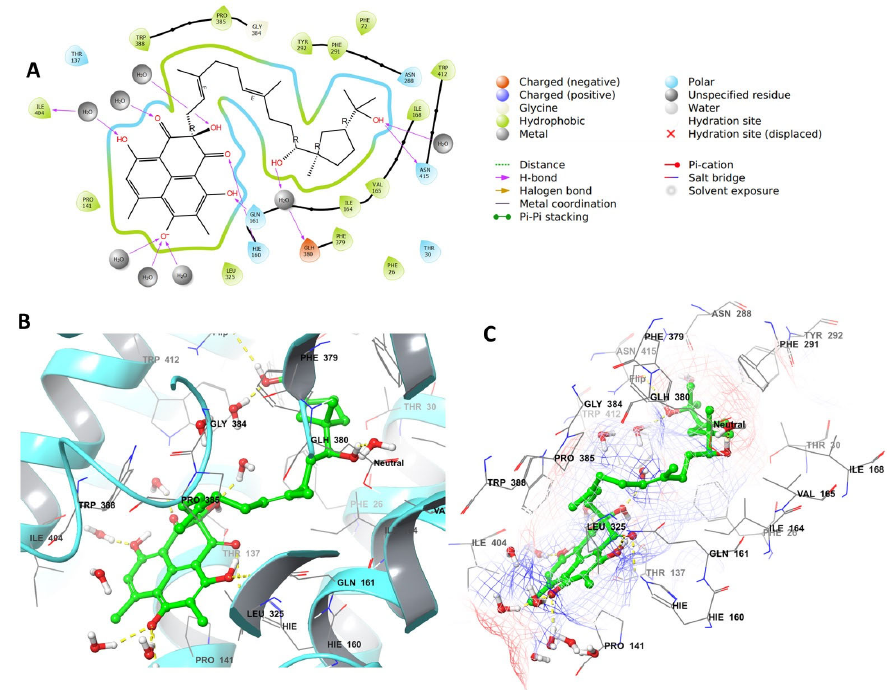
Figure 17. GLUT1 ‐ 64 complex after docking. ( A ) 2D view of the binding interactions between compound 64 when complexed with GLUT1 (PDB: 5EQG). ( B ) 3D view of the binding interactions between compound 64 with the amino acids residues of GLUT1 within 3Å radius around the ligand (PDB: 5EQG). ( C ) The 3D view of the GLUT1 ‐ 64 complex with the mesh surface indicating the electrostatic potential around the ligand.